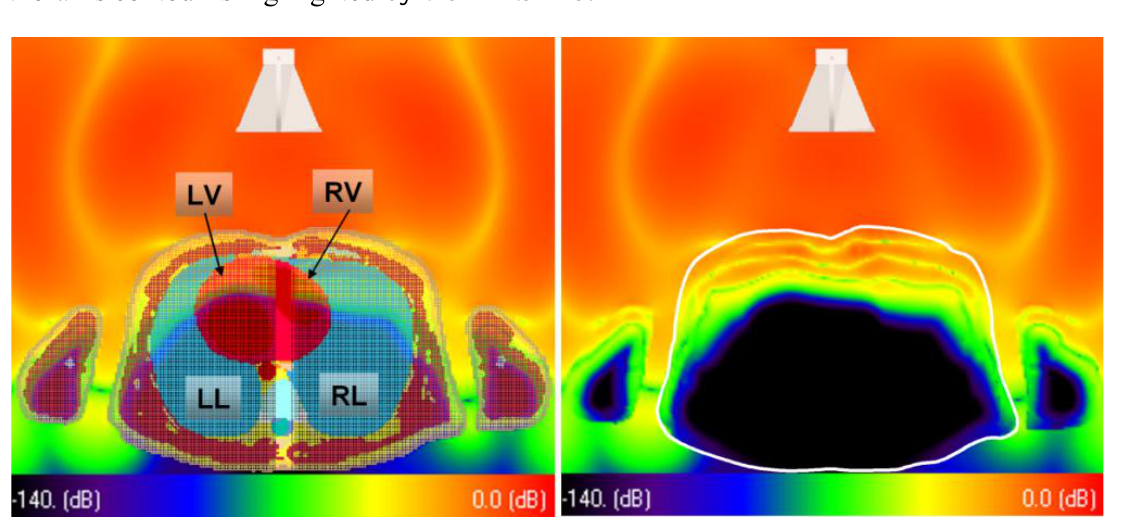
Figure 16. Field distribution in an axial cross section extra- and intra-corporal. Left : with tissue mesh. Right : without the mesh, showing the wave propagation intra-corporal. The thorax’s contour is highlighted by the white